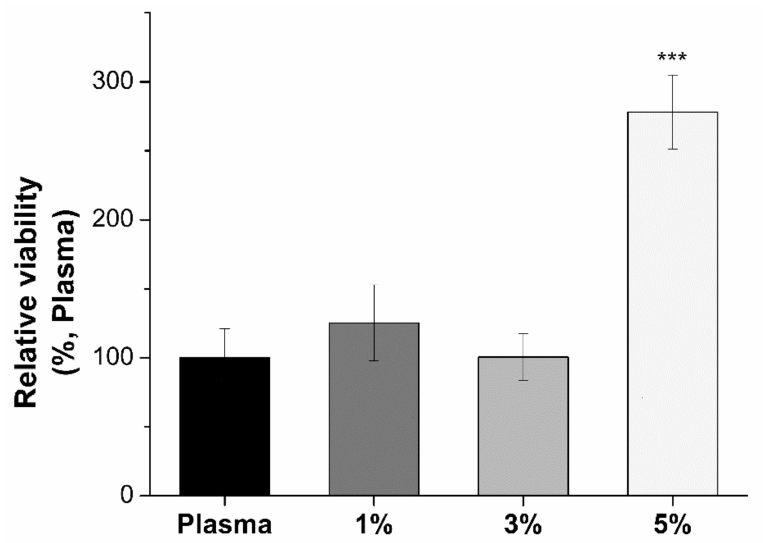
Figure 7. Relative viability of keratinocytes in plasma and hybrids hydrogels by MTS assay at day 2. Data are reported as mean ± SD (n = 4). ANOVA analysis were performed for 1, 3 and 5% hybrid plasma-SKS hydrogels respect to plasma samples (**** p <